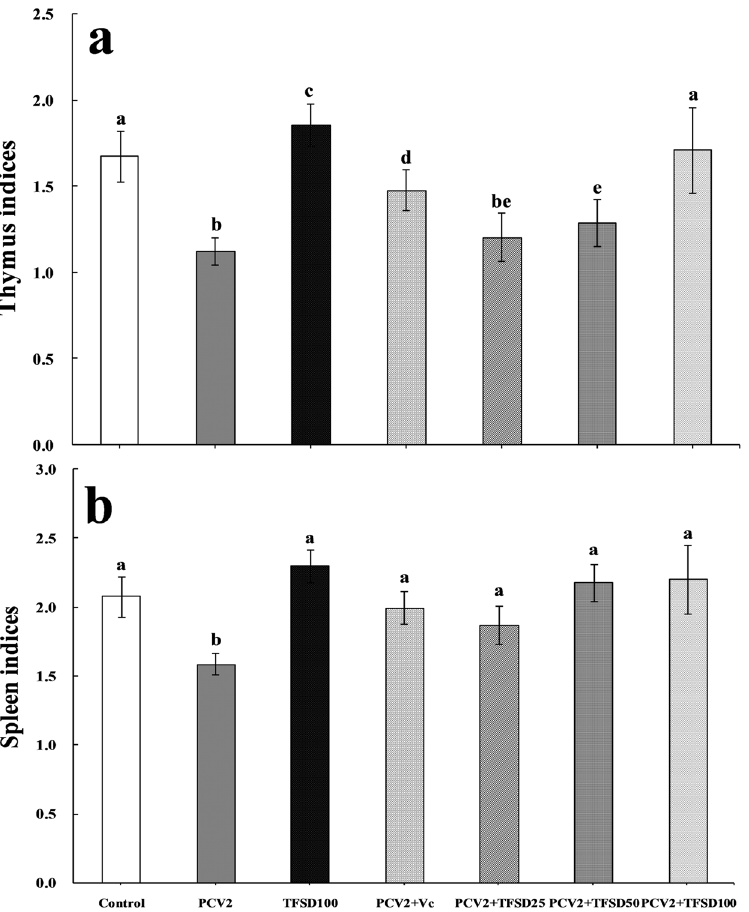
Figure 4. Effect of TFSD on the spleen and thymus indices of PCV2 infected mice. The spleen and thymus indices were calculated as the weight of spleen or thymus to the mice’s body weight (mg/g). Data are presented as mean ± SD (n = 10). Bars with different letters are statistically different ( P <